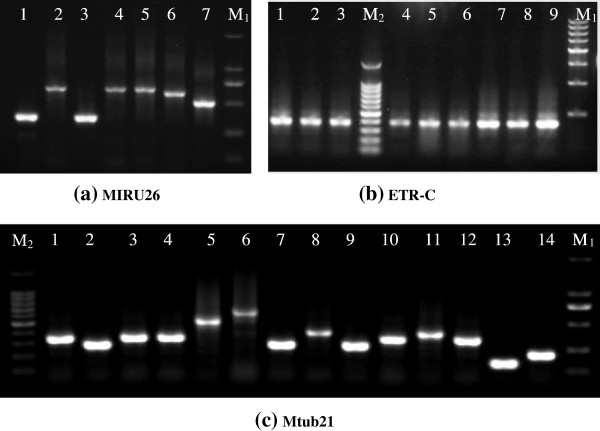
Length polymorphisms of three loci{(a) MIRU26, (b) ETR-C, and (c) Mtub21} for some of the tested clinical isolates from Jiangxi Province, China (M1: 100 bp DNA Marker, M2: 50 bp DNA Marker).